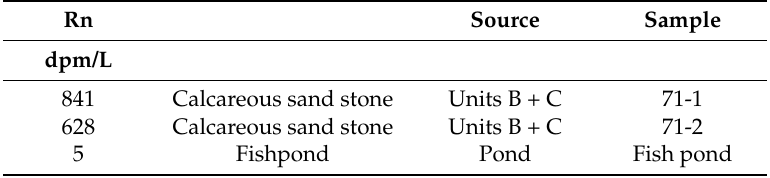
Table 2. Radon activity in groundwater and fish pond water (dpm/L) from Aug 2010 and May 2011.